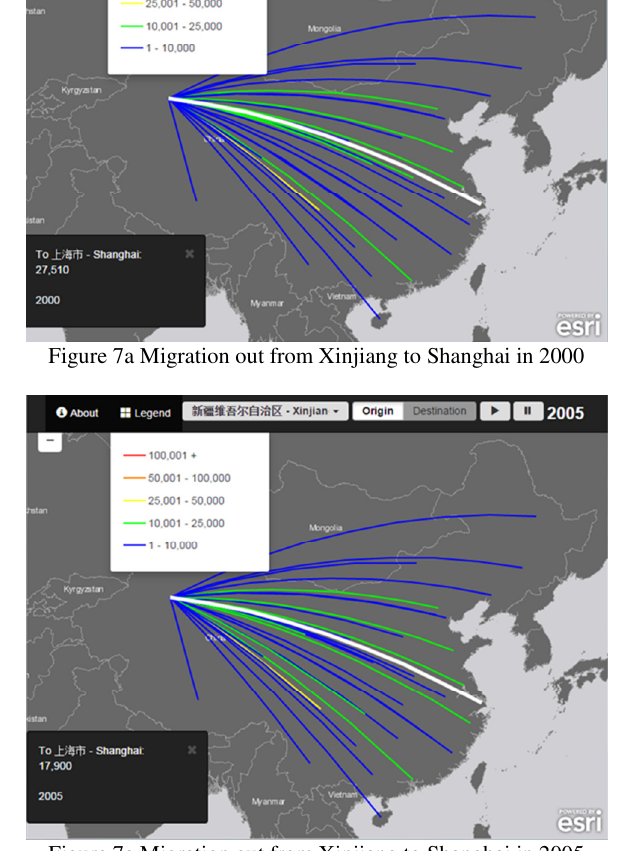
a table with four columns: Origin, Destination, Time, and Measurement. The hosting server requires an ArcGIS for Server license, but the users only need a web